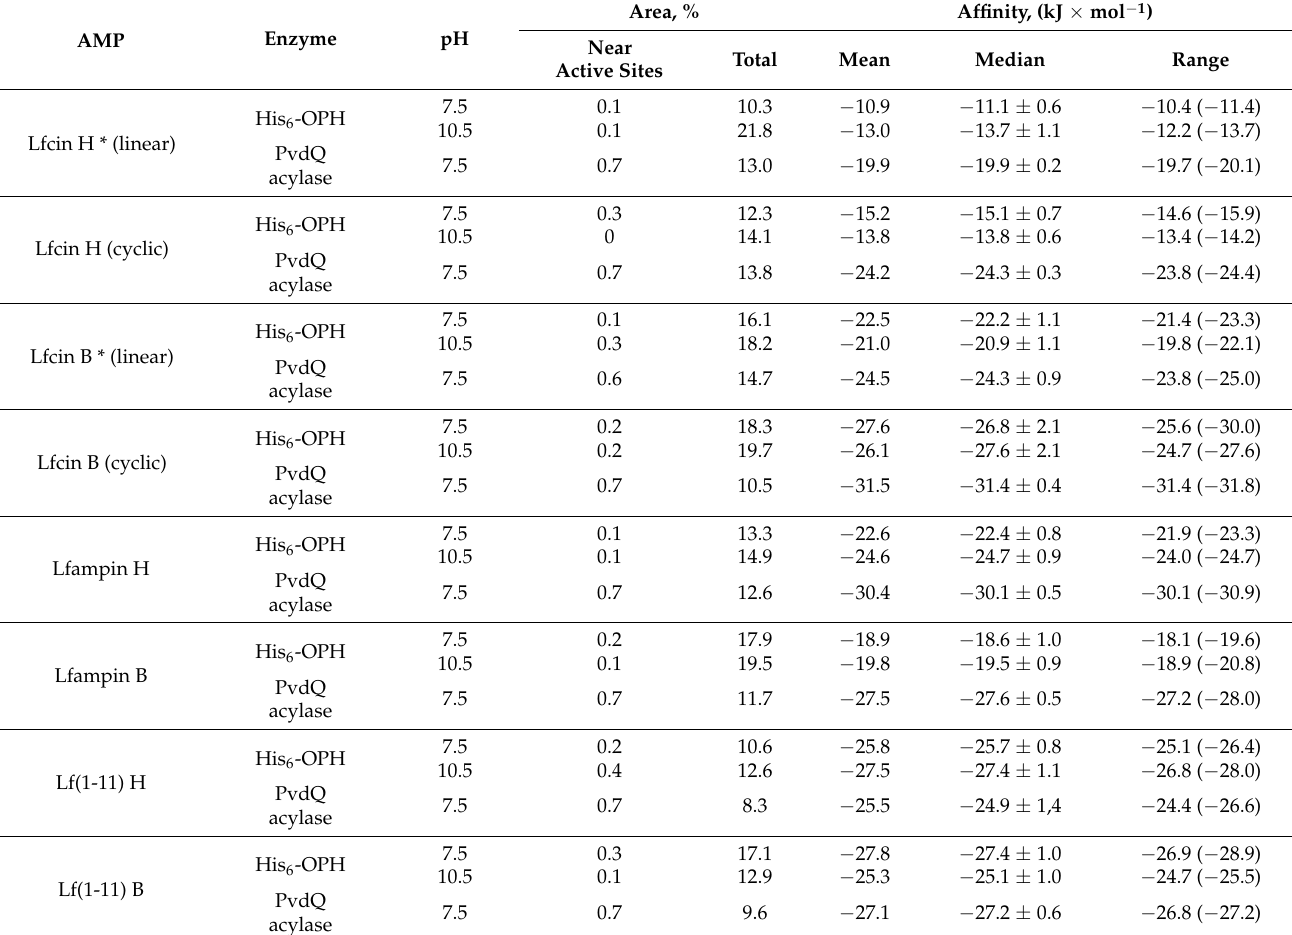
Table 2. Values of occupied area and affinity of human (H) and bovine (B) lactoferrin-derived AMPs to the surface of His 6 -OPH dimer and PvdQ